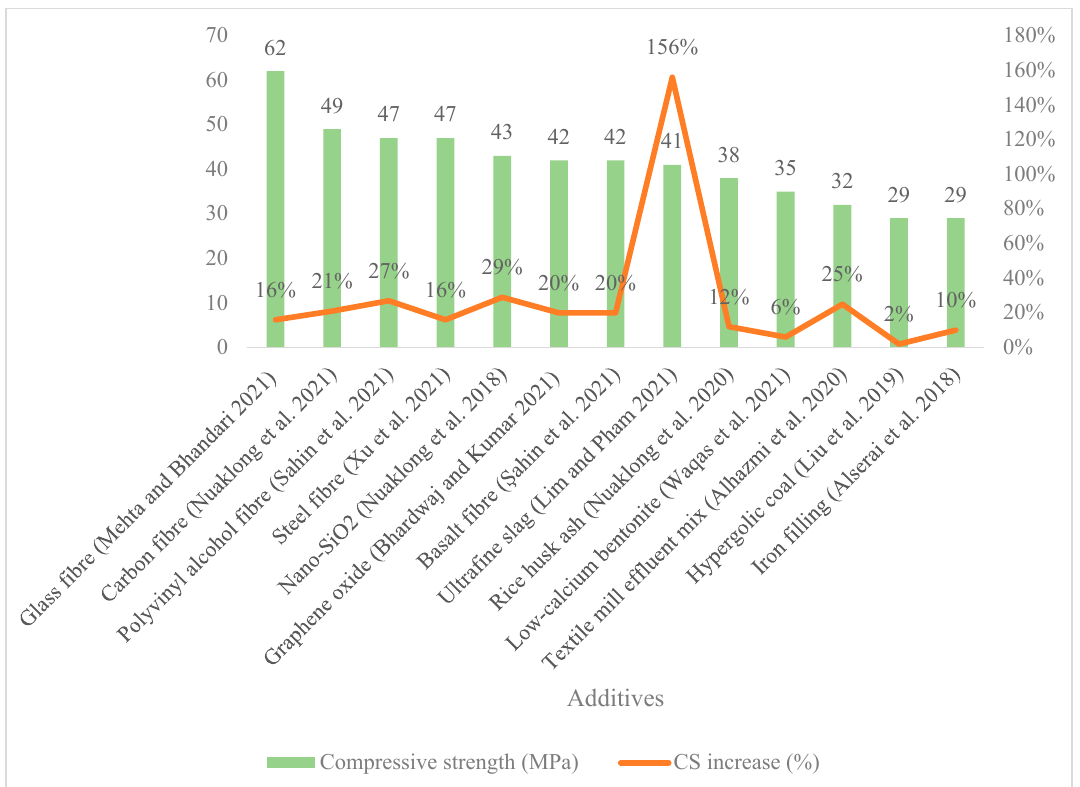
Figure 4. Maximum CS for RCA-based GC using various additives [17,32,33,36,37,44,58–60,64,70,71,76]. Waqas, Butt, Danish, Alqurashi, Mosaberpanah, Masood, and Hussein [36] used low- calcium bentonite. They replaced 5%, 10%, 15%, and 20% of high-calcium fly ash with bentonite, while they used a NaOH/Na 2 SiO 3 ratio of 2 and a NaOH molarity of 12. They pointed out that replacing 10% of bentonite increased the compressive strength and split tensile strength by 5.71% and 8.69%, respectively, compared with 5% bentonite replacement. They also stated that more than 10% replacement harms the compressive strength.